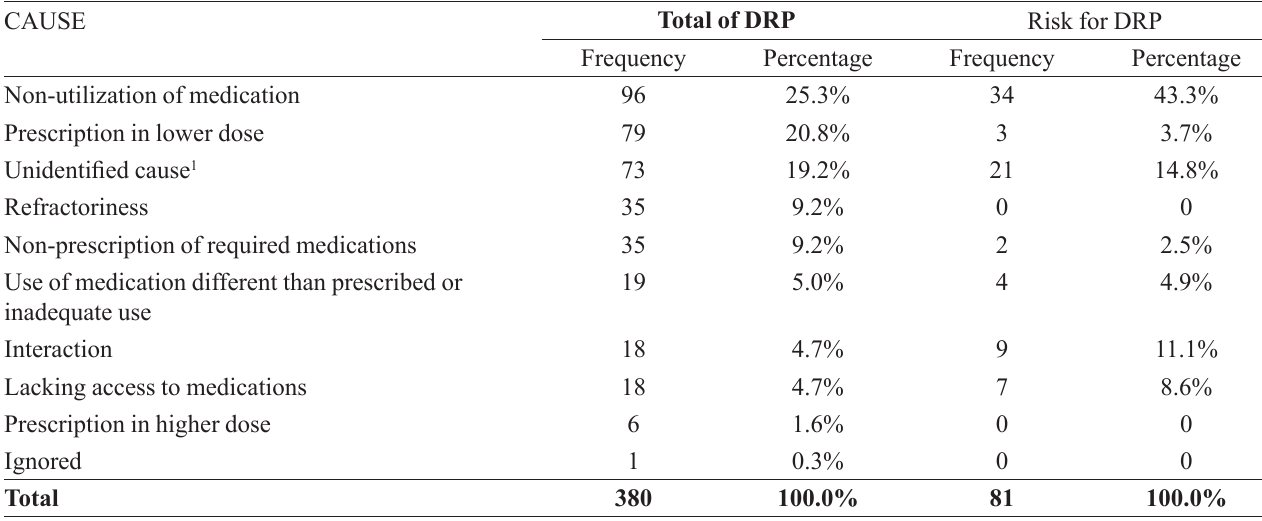
TABLE V – Main identified causes for DRP found at FECUNP from 2001 to